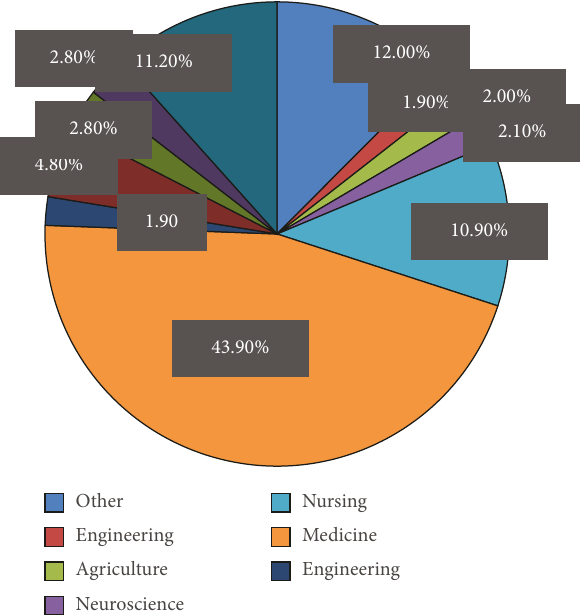
Figure 4: Pie chart depicting article distribution by disciplines for scoping review articles.